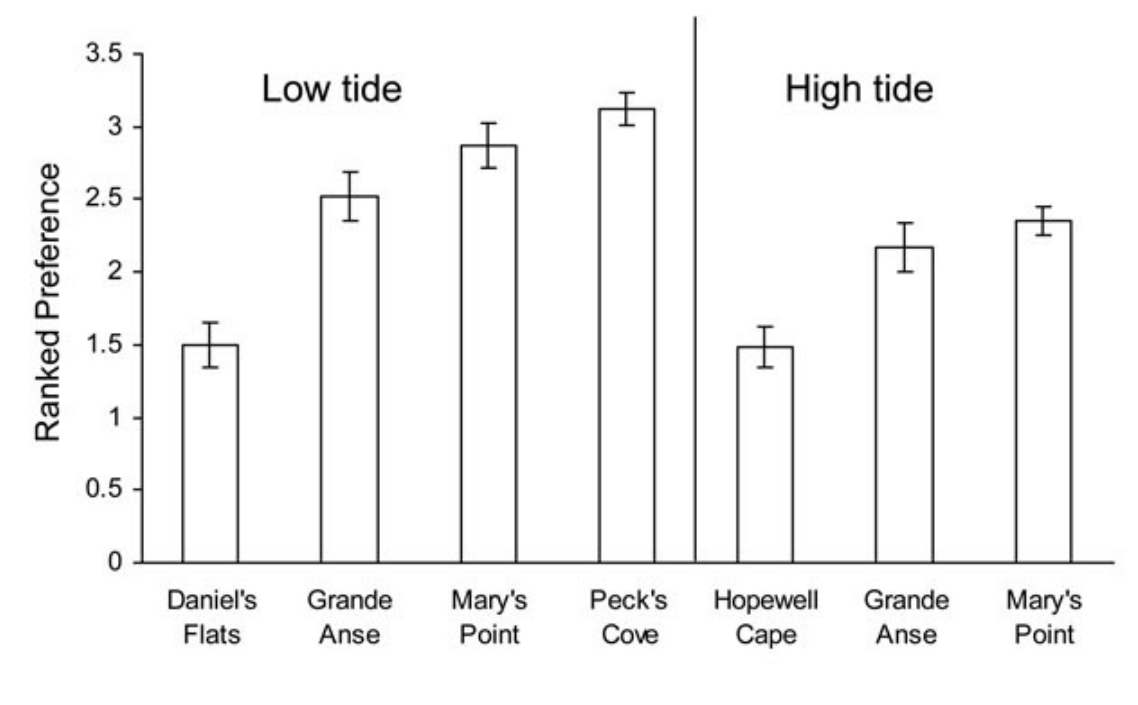
Fig. 3. Ranked preference of site usage by sandpipers in Chignecto Bay for low and high tides in 2005. Lower numbers indicate stronger site selection; i.e., the rank closest to 1 indicates the preferred site. Error bars are ± 1